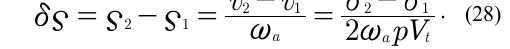
Table 3. Planck constant values, h, and autolocalizon masses, ma